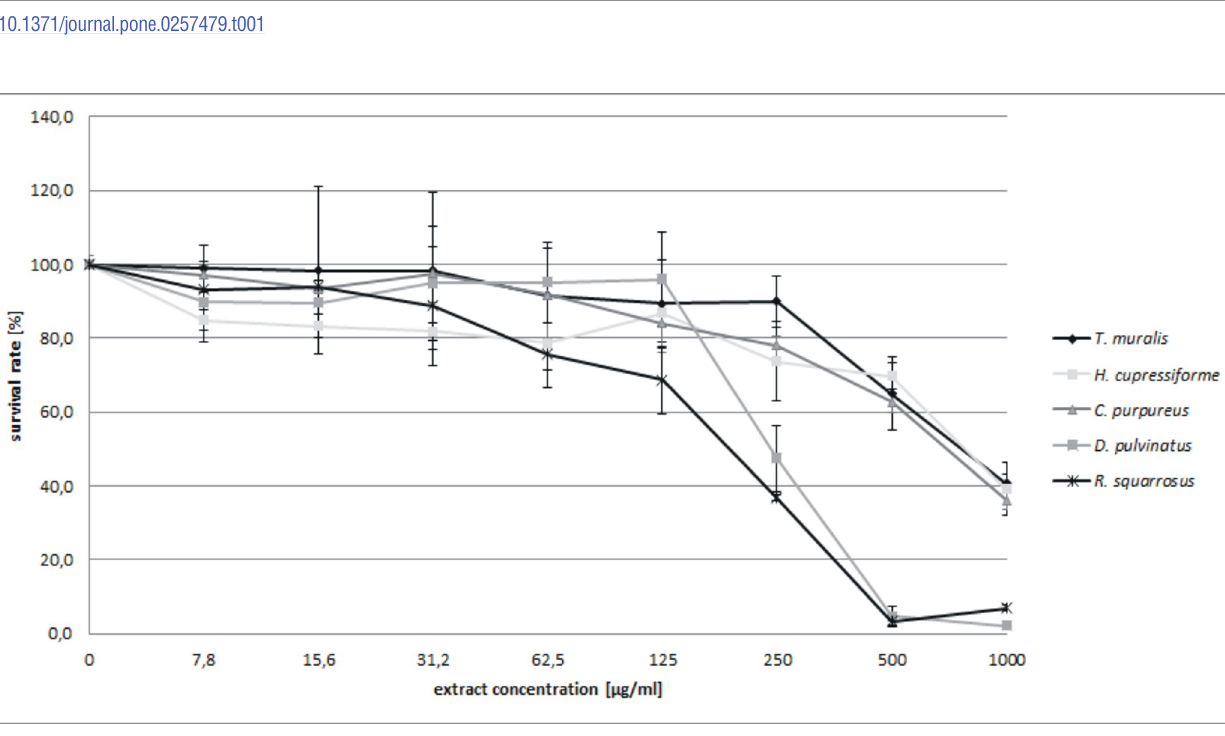
Fig 5. Dose dependent effects of ethanolic moss extracts on L929 cells after 24 h of exposure. Cell viability was quantified using MTT colorimetric method. The results are expressed as mean ± SD. Statistical significance (p < 0.05) was calculated with Kruskal-Wallis test.